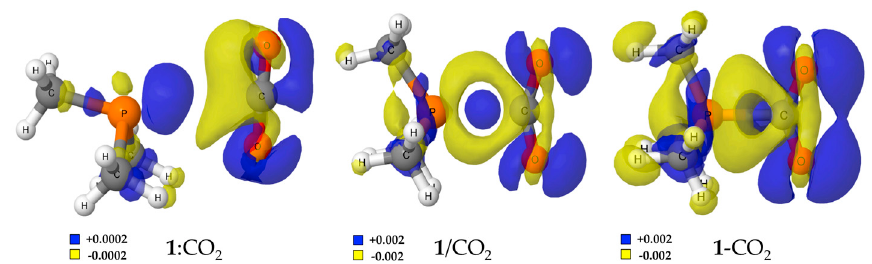
Figure 4. Electron density shift maps for the stationary points of the 1 + CO 2 energy profile. Positive and negative values are shown in blue and yellow, respectively. The surfaces for the complex correspond to ± 0.0002 au and in the transition state (TS) and adduct to ± 0.002 au.